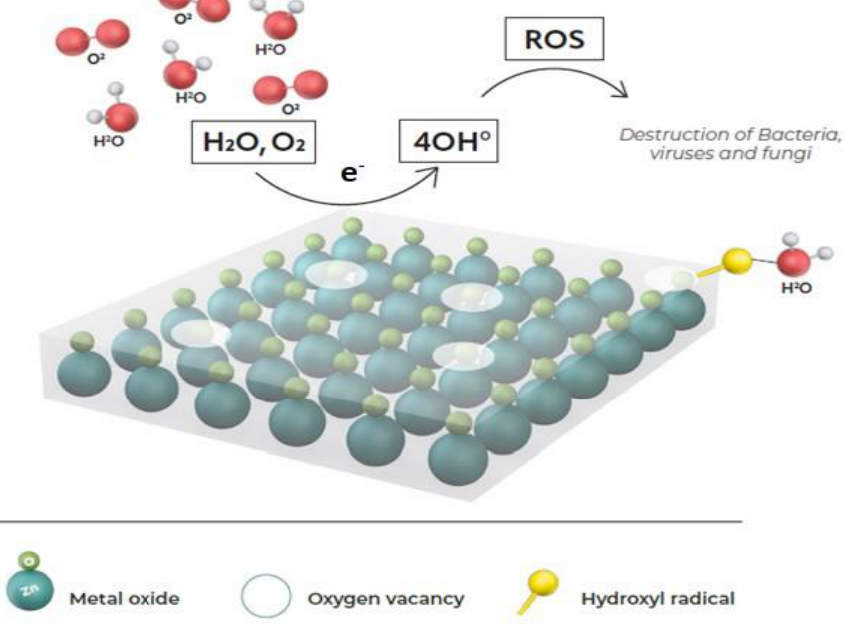
Figure 1. Mechanism of action of oxide mineral microspheres.